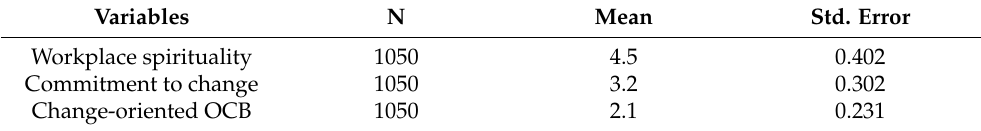
Table 1. Variable